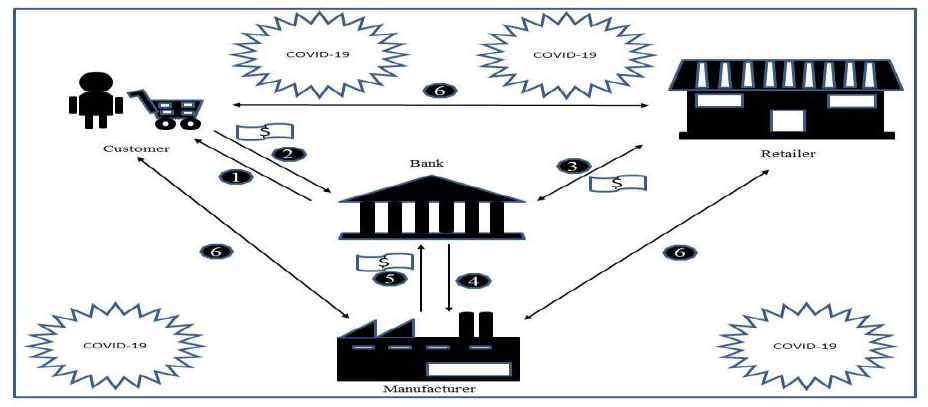
Figure 6. COVID-19 and trade finance in emerging markets.